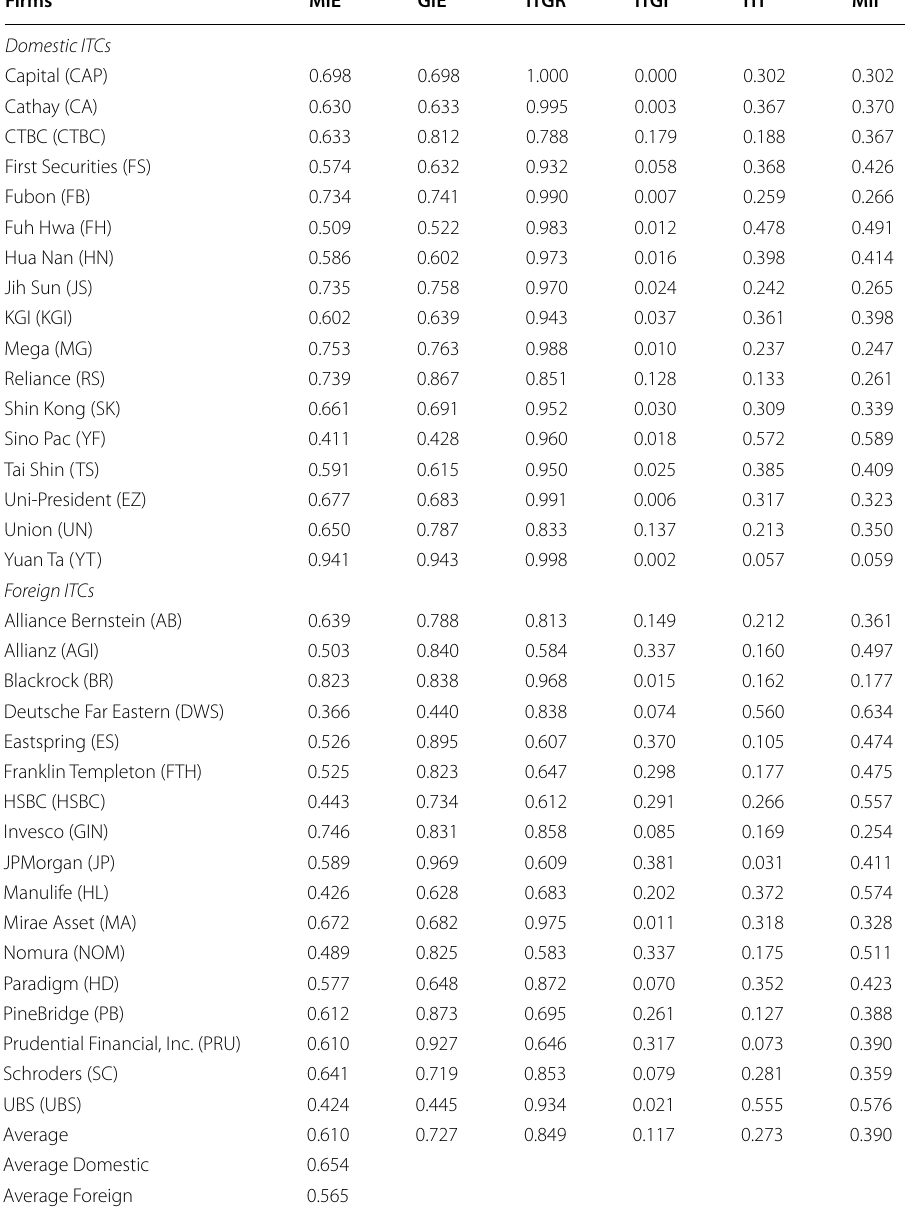
Table 7 Average investment efficiencies and metafrontier inefficiencies from 2011 to